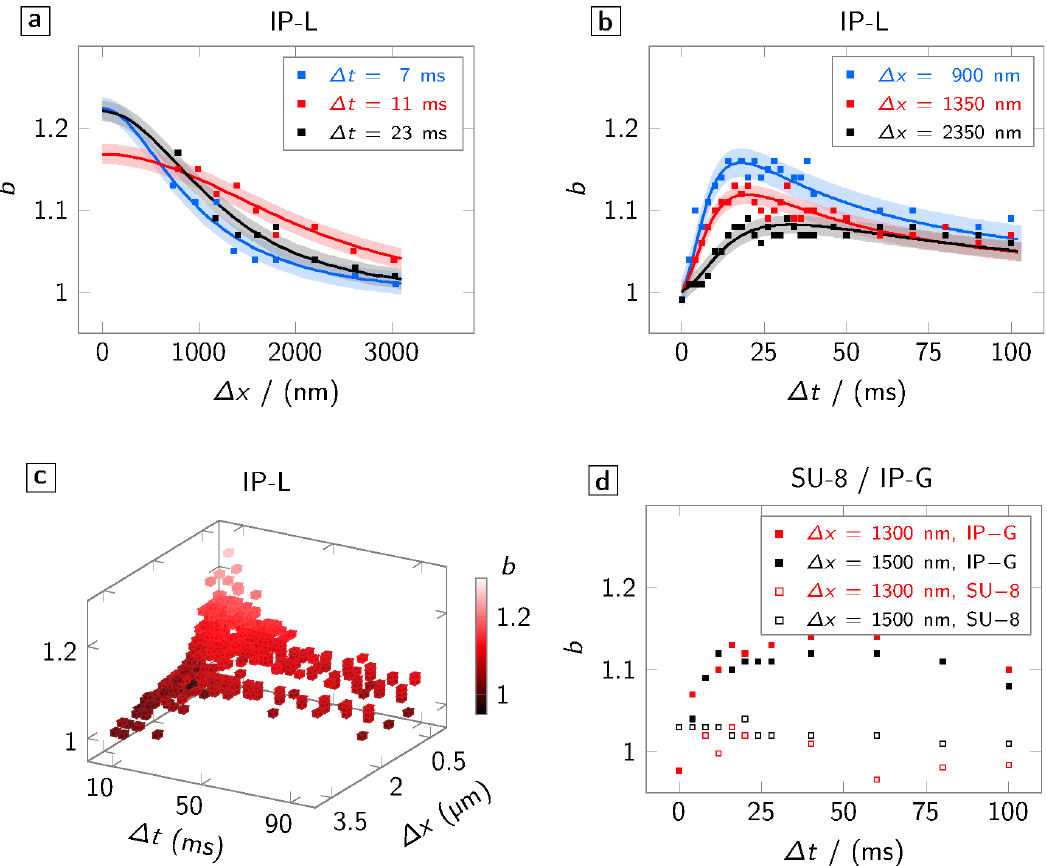
Figure 4. Spatio-temporal characteristics of the broadening b = w t / w l in the liquid, radical based photo resist IP-L. Squares indicate the measured data, the solid line a model fit to the experimental values, and the underlay the corresponding mean-squared error. ( a ) Spatial characteristics of b for exemplary delays ∆ t ; ( b ) temporal characteristics of b for exemplary separations ∆ x ; ( c ) spatio-temporal characteristics of b ; and ( d ) comparison of the temporal characteristics of b in SU-8 (open squares) and IP-G (filled squares) for exemplary values of ∆ x